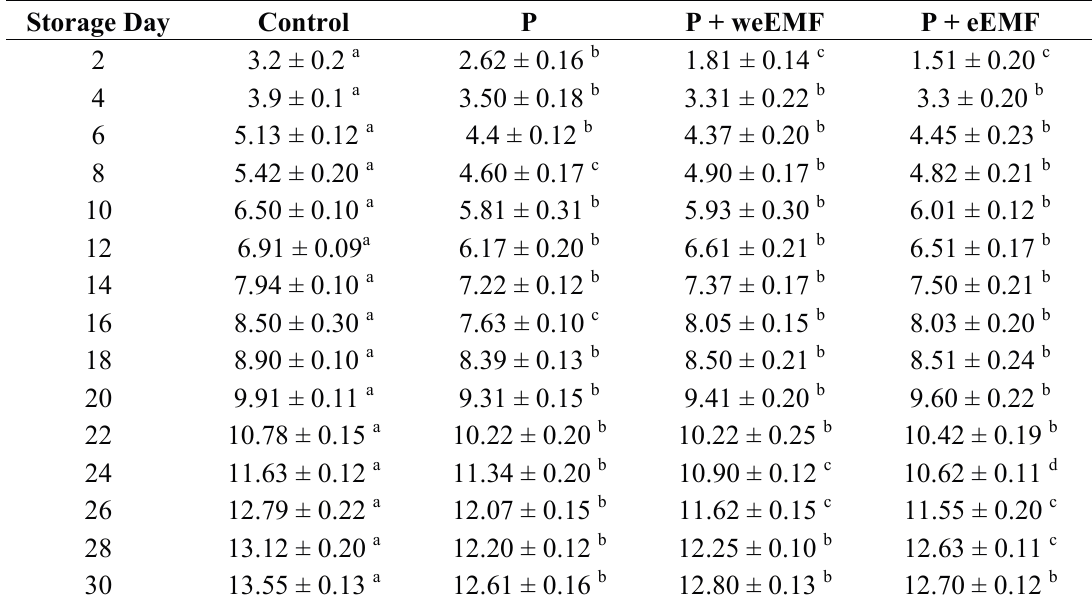
Table 2. Changes in weight losses (%) in the peppers stored at 6 °C during 30 days. Storage